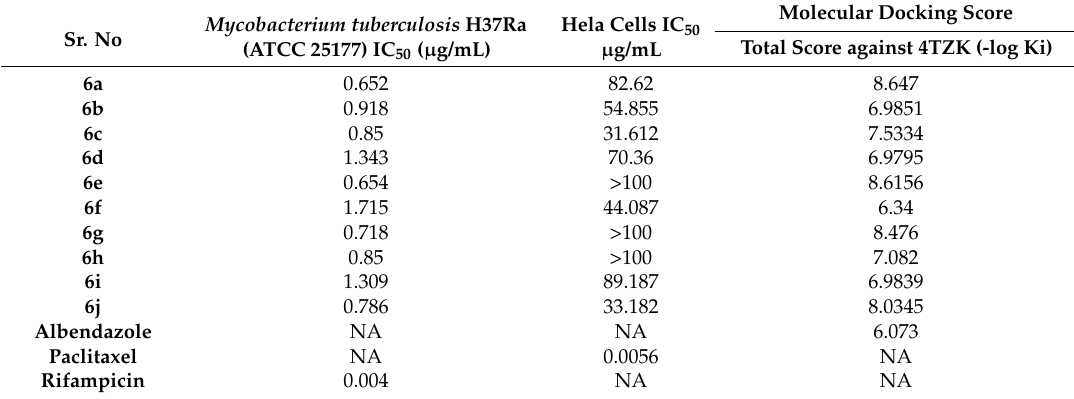
In-vitro anti-tubercular activity, cytotoxicity, and molecular docking of synthesized derivatives 6a – j